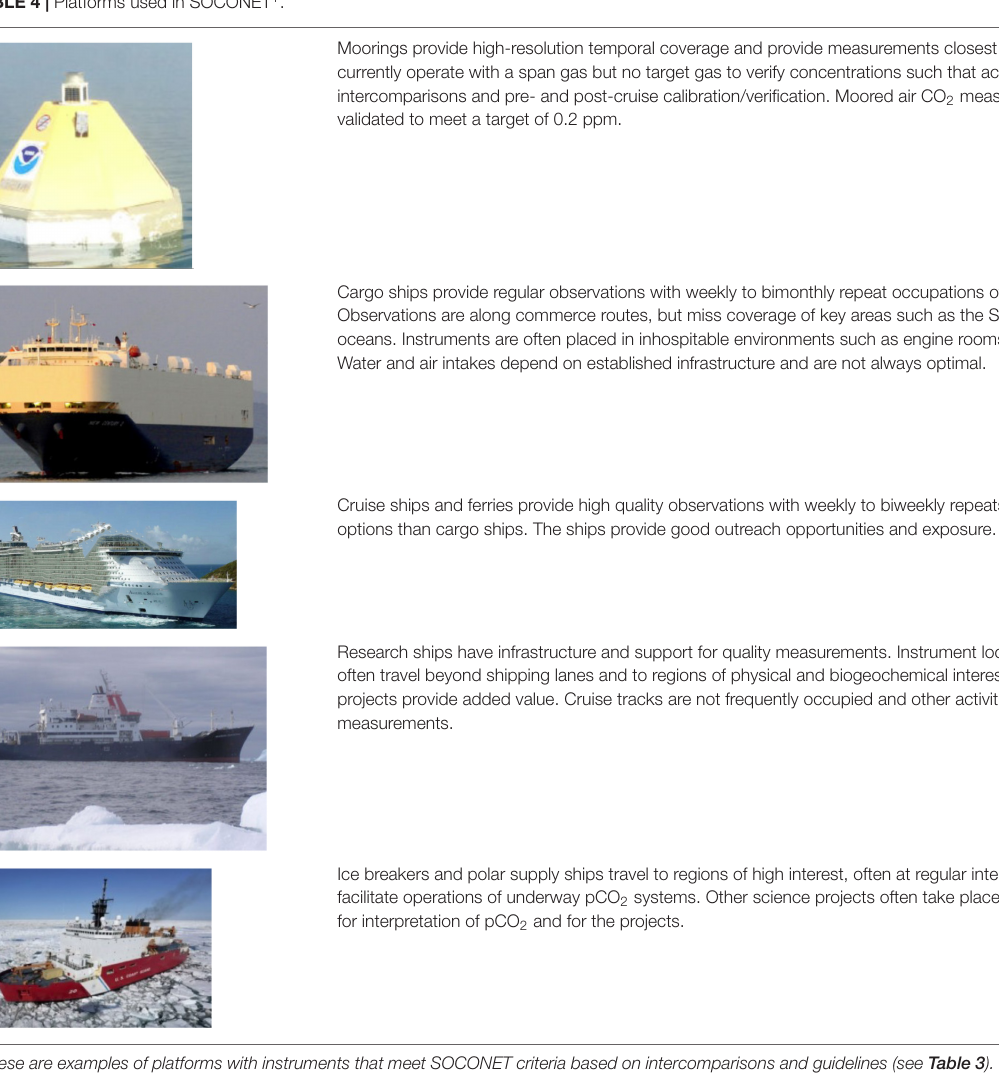
TABLE 4 | Platforms used in SOCONET 1